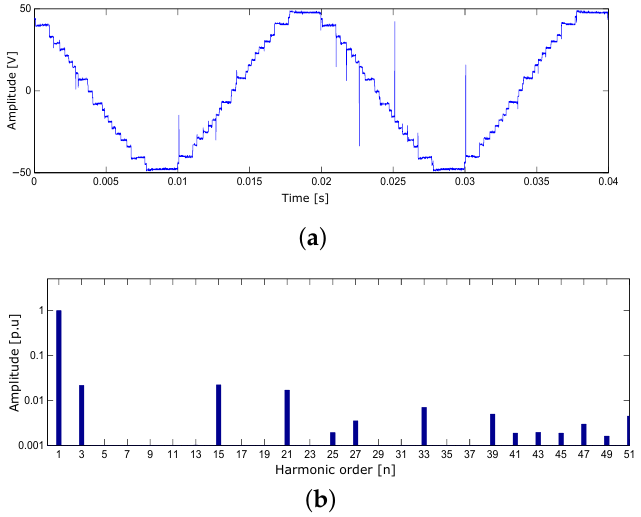
Figure 14. Results for experimental implementation of SHE and RL load; ( a ) output voltage waveform, ( b ) voltage harmonic spectrum.